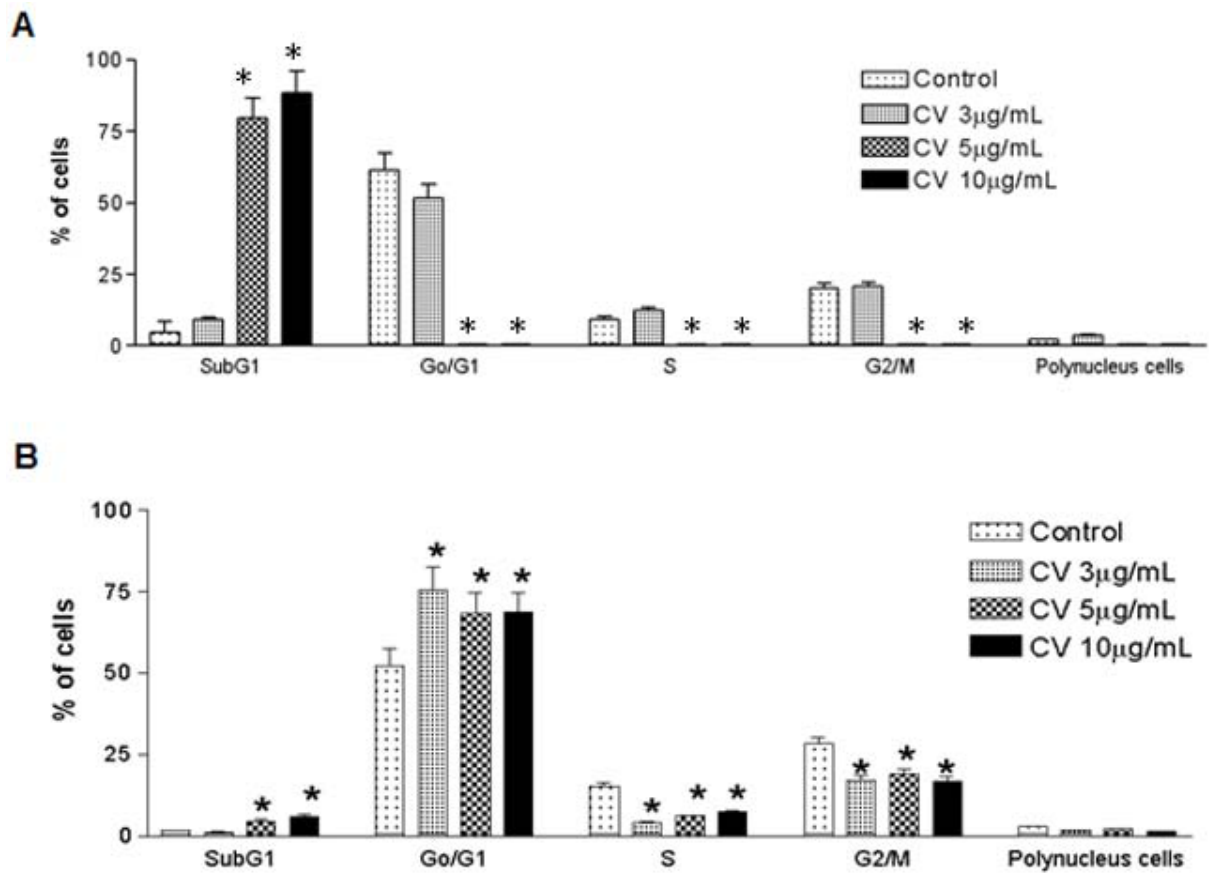
Figure 4. Flow cytometry analysis of DNA content in CV-treated cells: ( A ) GH3 cells and ( B ) RT2 cells. Brain tumor cells were treated with different CV concentrations for 48 hours. Cell cycle was analyzed by flow cytometry using propidium iodide. CV induced death and cell cycle arrest in brain tumor cells (*p < 0.01).